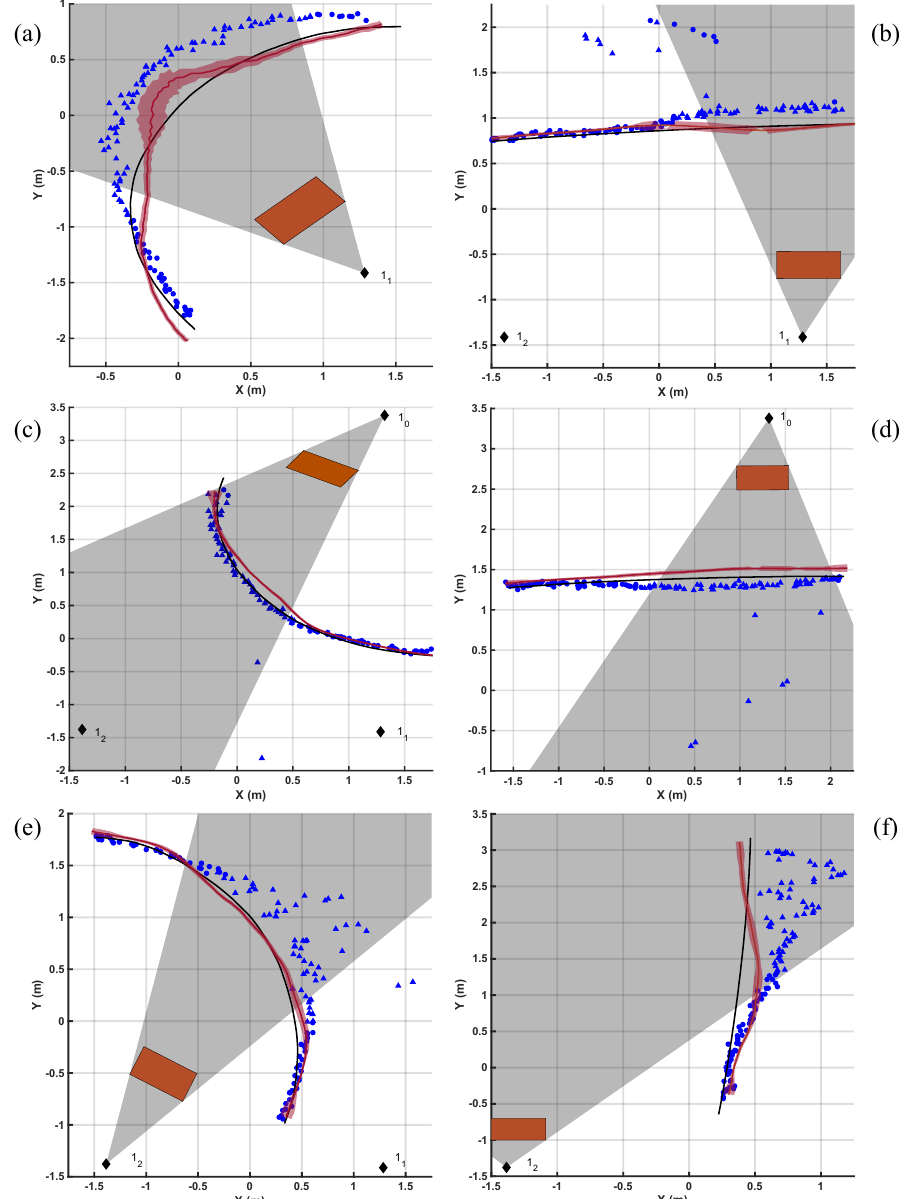
Figure 12. The six subfigures ( a – f ) represent dynamic tests, with the robot moving along six different trajectories. ( a , c , e ) represent circular trajectories, while ( b , d , f ) are linear ones. The black line represents the position measured by the Vicon system, while the blue markers are the coordinates estimated originally by the Decawave kit. The marker shapes are triangular if the SVM classified the point as collected in NLOS conditions or circular when LOS was predicted. The red line in the graph is the corrected trajectory with the shaded area showing the variability computed as standard deviation within the moving average window. The black diamonds show the positions of the anchors while the red rectangles represent the position of the obstacles. Finally, the grey area is a rough estimate of the field of view in which the anchor operates in NLOS